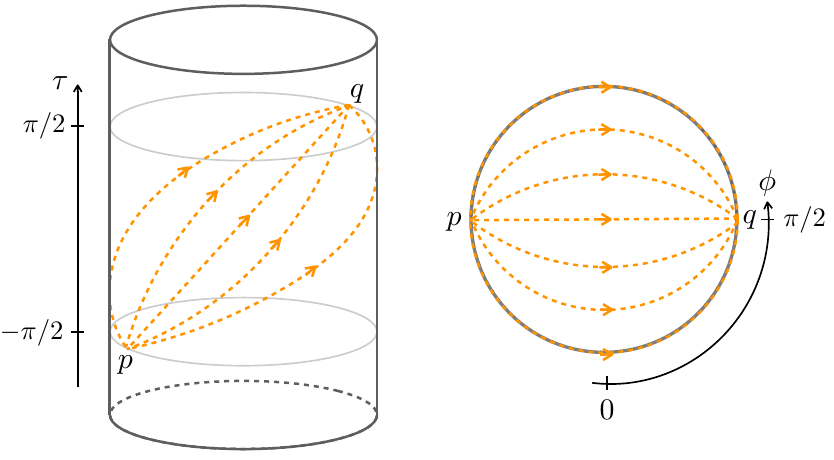
Figure 4 . The orange dotted curves in the left panel show some null geodesics launching from p : ( τ, r, φ ) = ( − π/ 2 , ∞ , − π/ 2) in global AdS 3 . All such geodesics reach q : ( τ, r, φ ) = ( π/ 2 , ∞ , π/ 2) . The right panel shows the projection onto a time